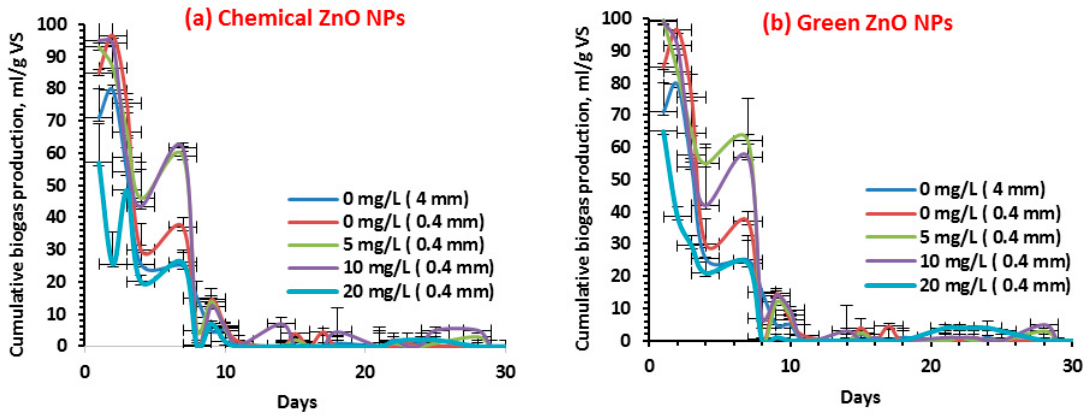
Figure 13. Mean rate percentage of daily biogas production using ( a ) chemical and ( b ) green synthesized ZnO NPs.